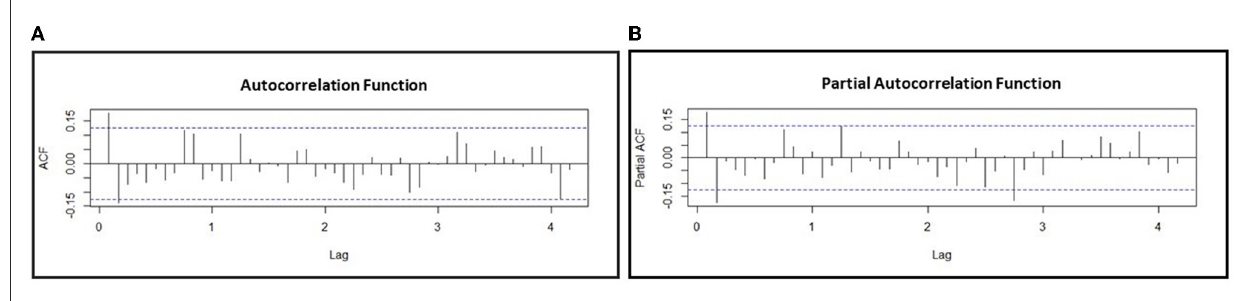
FIGURE3 The chart of (A) Auto-Correlation Function (ACF) and (B) Partial Auto-Correlation Function (PACF) for determining the order of ARIMA model.